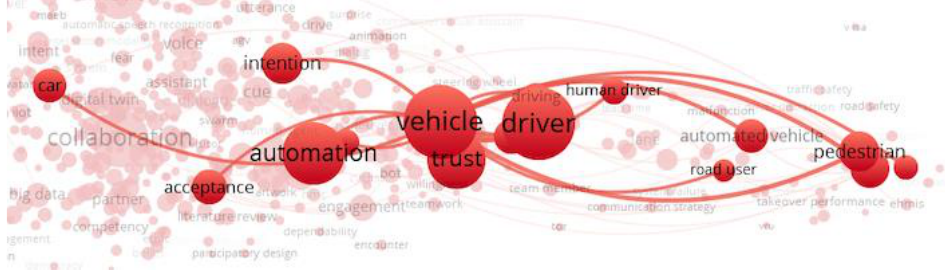
Figure 13. Vehicle dependency.